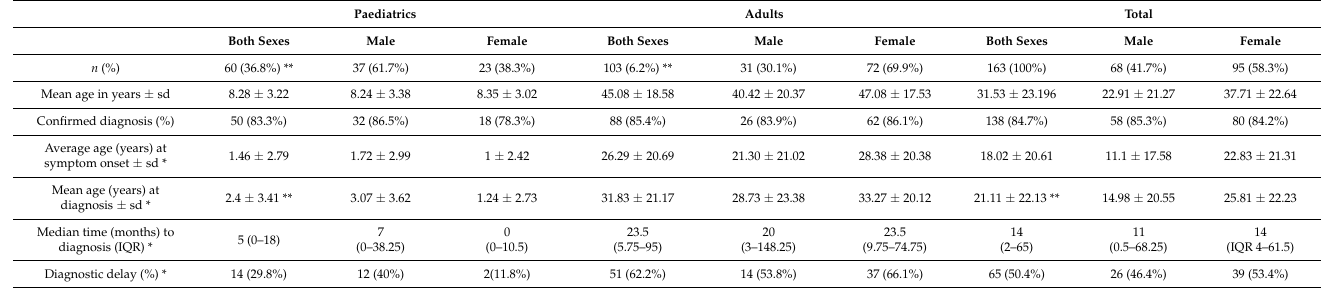
Table 1. Socio-demographic and diagnostic characteristics of paediatric and adult patients.